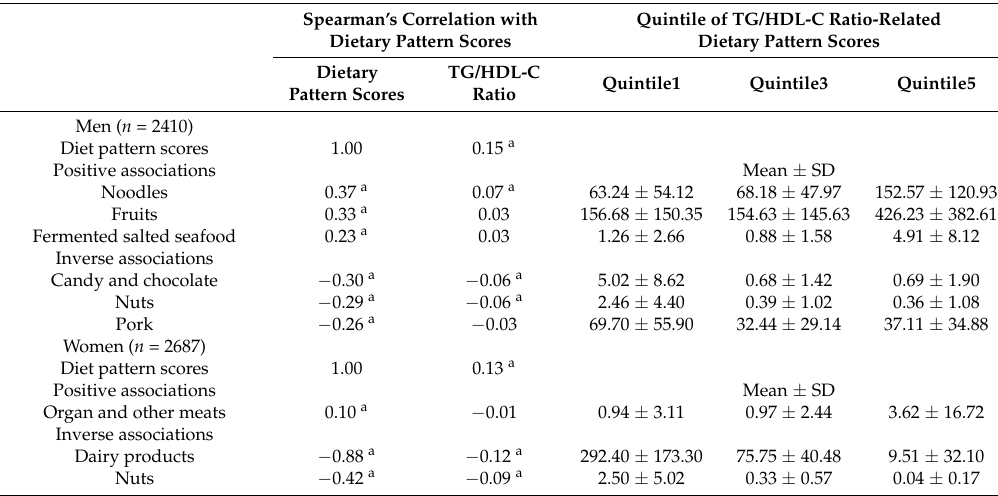
Table 1. Spearman correlation coefficients between dietary pattern scores, selected foods, and the TG/HDL-C ratio, and the mean intake of selected food groups (g/day) according to the quintile of dietary pattern scores.